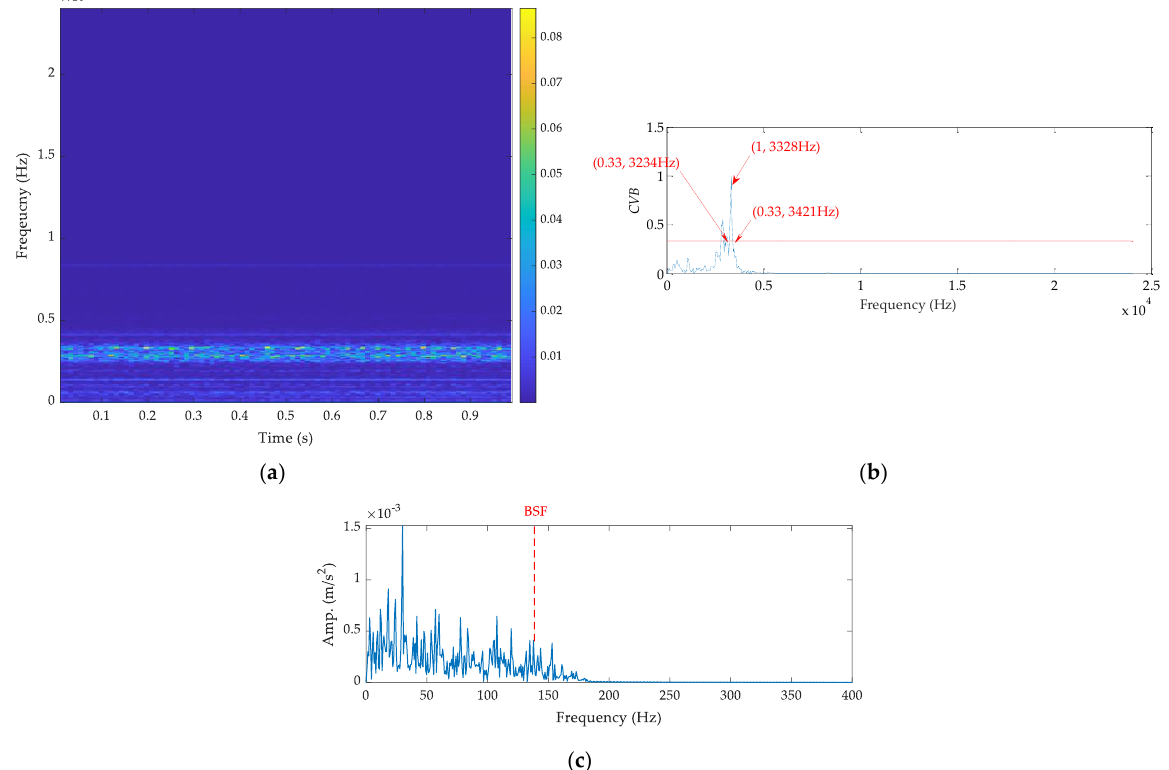
Figure 21. The results by CVB technology for the outer fault signal: ( a ) time – frequency spectrum, ( b ) CVB vs. frequency, and ( c ) SES for the filtered signal.